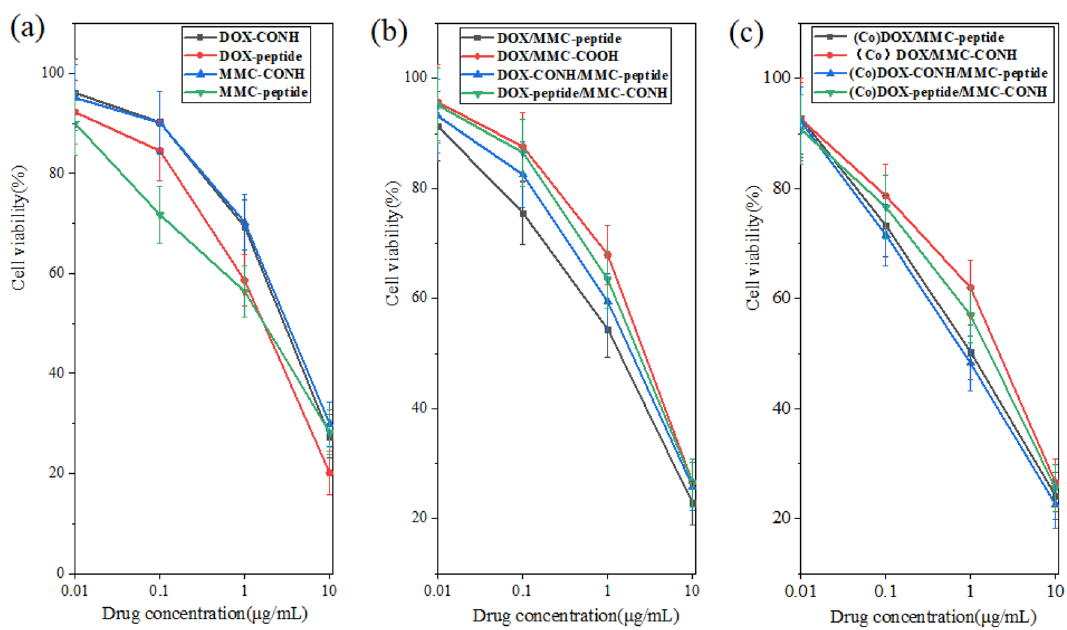
Figure 6. In vitro cytotoxicity of ( a ) DOX-CONH, DOX-peptide, MMC-CONH, MMC-peptide ( b ) DOX/ MMC-peptide, DOX/MMC-COOH, DOX-CONH/MMC-peptide, DOX-peptide/MMC-CONH ( c ) (Co)DOX/ MMC-peptide, (Co) DOX/MMC-CONH, (Co)DOX-CONH/MMC-peptide, (Co)DOX-peptide/MMC-CONH against the drug resistant HepG2 cells. Data were given as mean ± SD (** p <